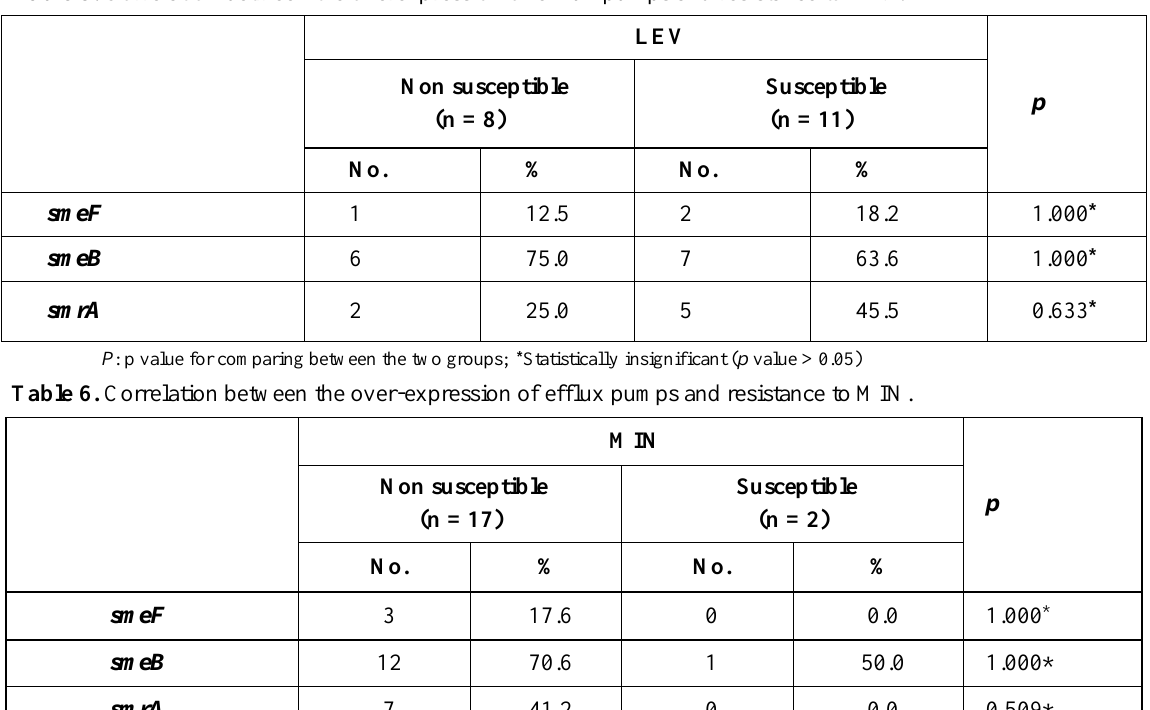
Table 5. Correlation between the overexpression of efflux pumps and resistance to LEV.